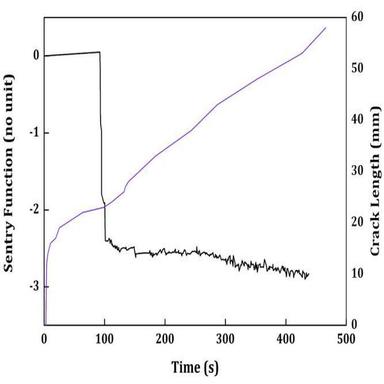
Sentry function and crack length progression for specimen C.